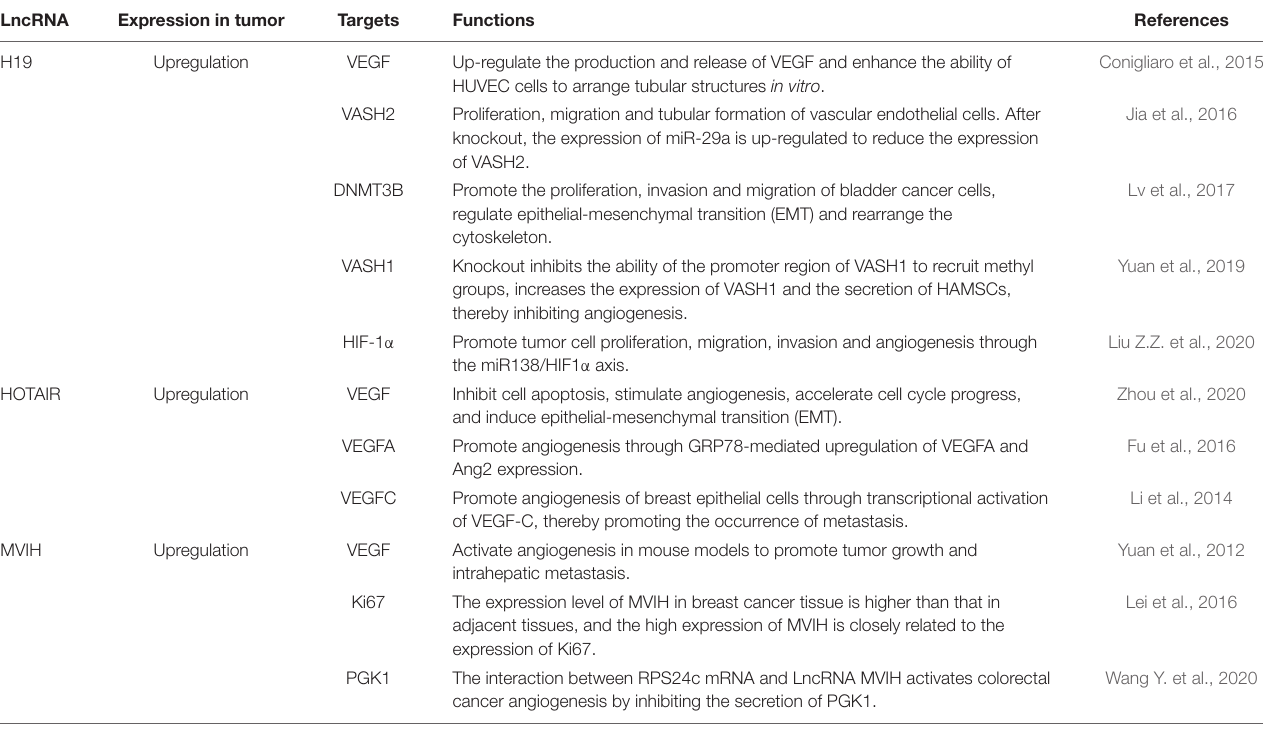
TABLE 2 | Common lncRNA targets and functions in regulating tumor angiogenesis.